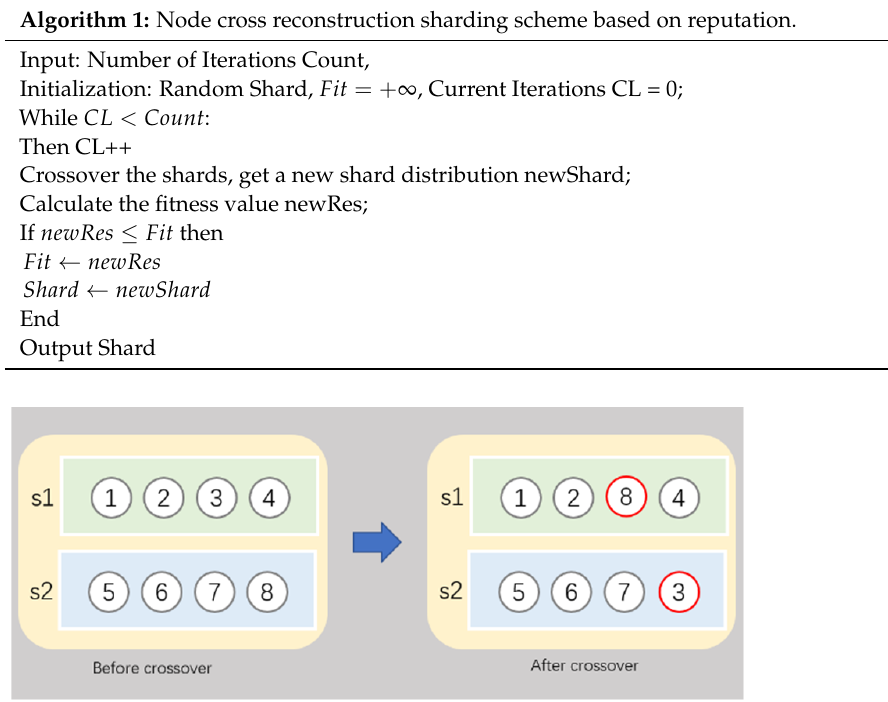
Algorithm 1: Node cross reconstruction sharding scheme based on reputation.